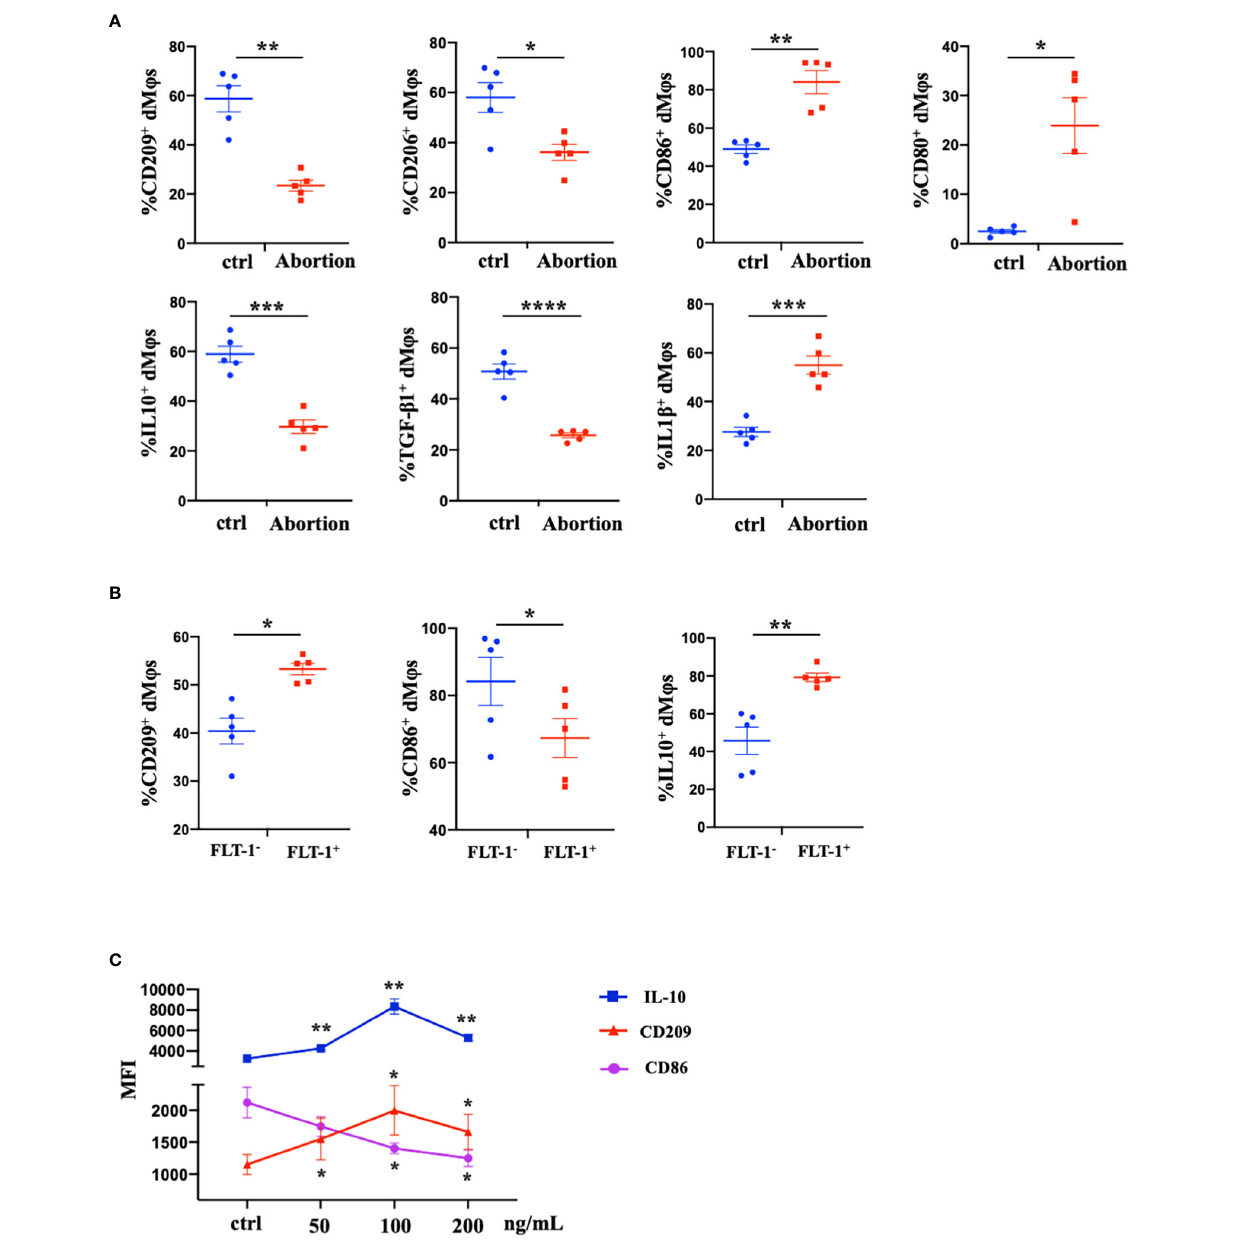
FIGURE 2 The decreased PlGF/FLT-1 expression contributed to the imbalance of M1/M2 paradigm at the maternal-fetal interface in early spontaneous abortion. (A) Flow cytometry (FCM) analysis of immune pro fi les (the expression levels of CD209, CD206, CD86, CD80, IL-10, TGF- b 1, and IL-1 b ) in decidual macrophages (dM j s) from normal pregnancy (n=5) and spontaneous abortion (n=5). (B) The expression levels of CD209, CD86, and IL-10 in FLT-1 − (n=5) and FLT-1 + dM j s (n = 5) by FCM analysis. (C) The MFI levels of CD86, CD209, and IL-10 in dM j s by FCM analysis after 48 hour treatment with recombinant human PlGF (rhPlGF) at gradient concentrations (5 independent experiments). Data were analyzed by Student ’ s t-test, Wilcoxon rank-sum test, paired t-test, or Wilcoxon matched-pair signed-ranks test, and shown as mean ± SEM. * P < 0.05, ** P < 0.01, *** P < 0.001, and **** P < 0.0001. ctrl, control; MFI, mean fl uorescence